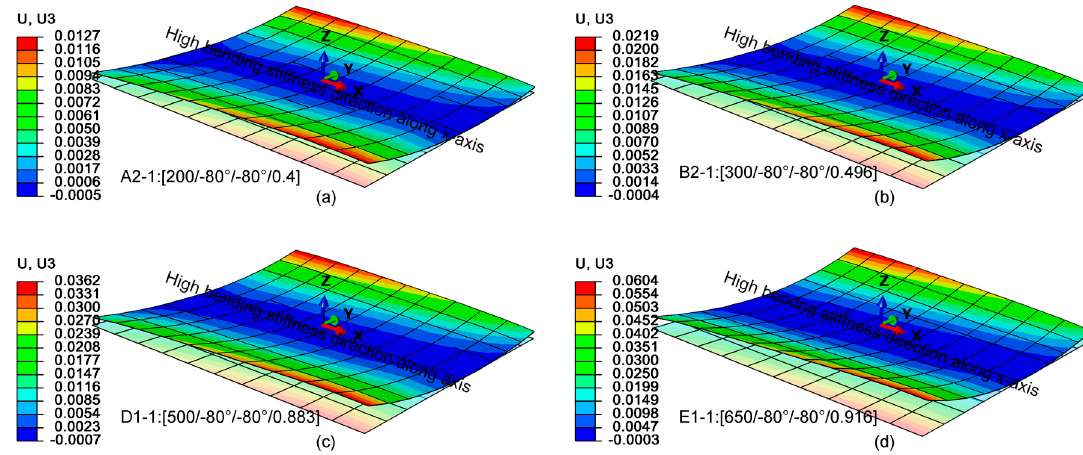
Figure 5. Cured shapes and deflections obtained at the end of the cool-down step (in meters) for sets A2-1, B2-1, D2-2, E2-2 in Table 5.